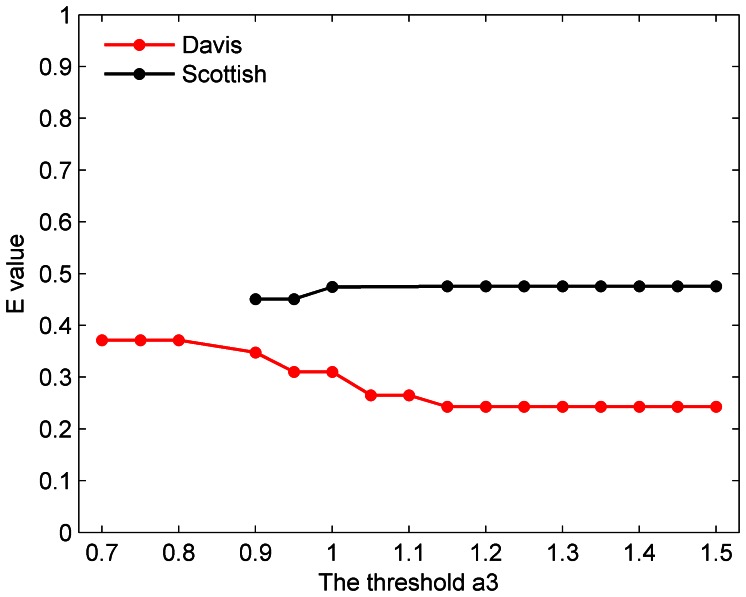
The relationship between a3 and E value.